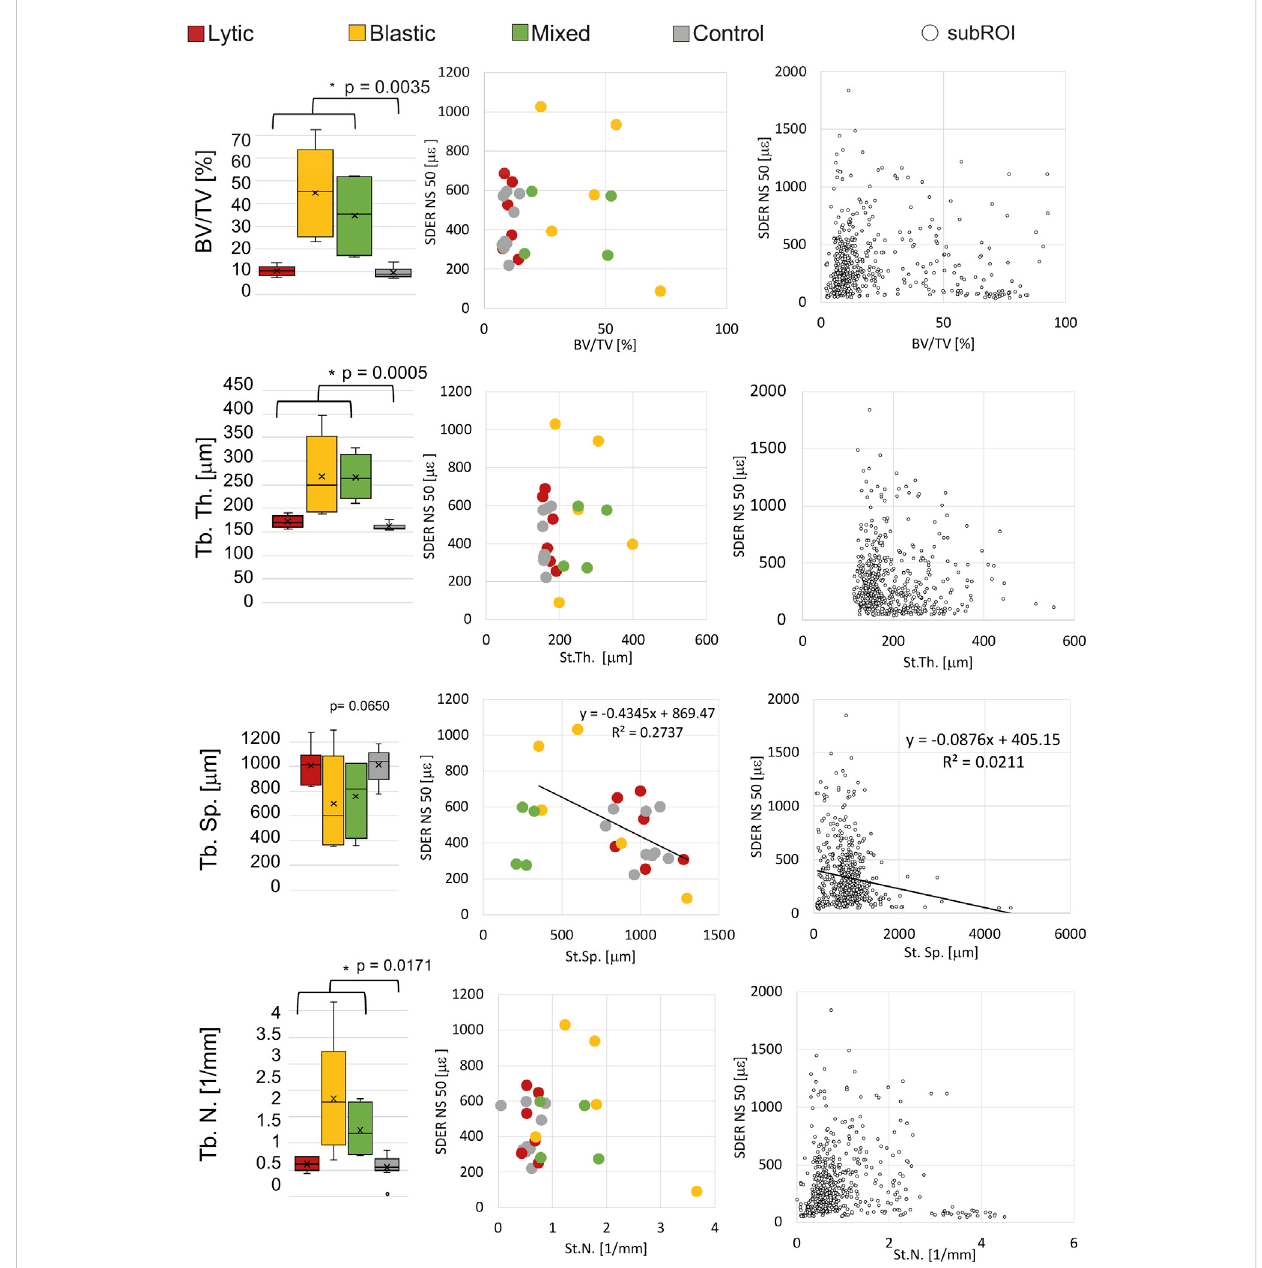
FIGURE 5 Left column: Boxplot of the microstructural parameters of metastatic vertebrae, grouped in vertebrae with lytic (red), blastic (yellow) and mixed (green)metastases, andcontrol(grey)vertebrae.The boxislimitedbythe fi rstandthethirdquartile.Whiskersrepresentthelowestandhighestdatapoint in the data set excluding any outliers (dots). Mean and median values among the group are represented by the cross and the horizontal line, respectively. Statistically signi fi cant differences (Mann-Whitney test) between the whole metastatic group and control group are highlighted with *. Central column: relationship between the microstructural parameters and the SDER evaluated on the whole vertebra, vertebrae with lytic (red), blastic (yellow) and mixed (green) metastases and control (grey) vertebrae. Right column: relationship between the microstructural parameters and the SDER evaluated in the local subROIs (data pooled for metastatic and control